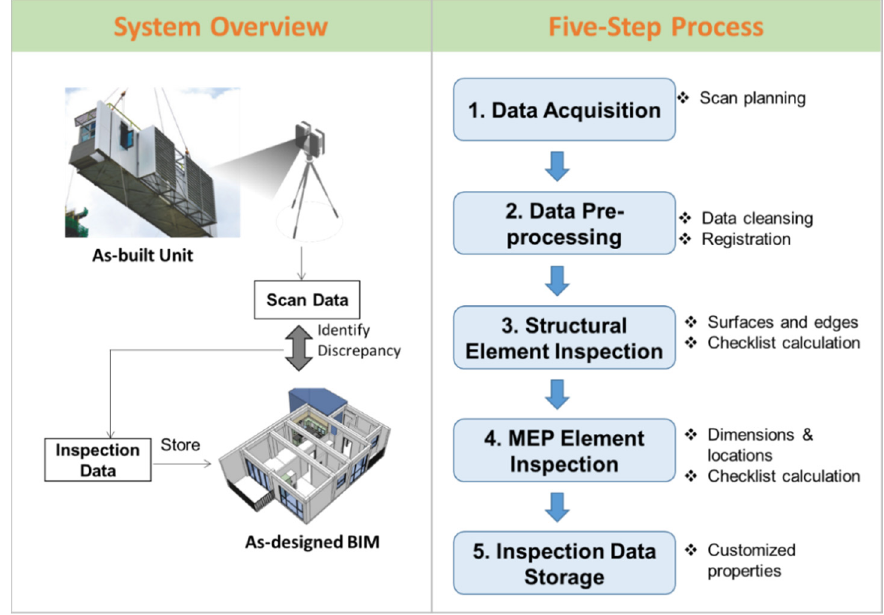
Figure 10. The overview and detailed five-step process of the developed geometric quality inspection